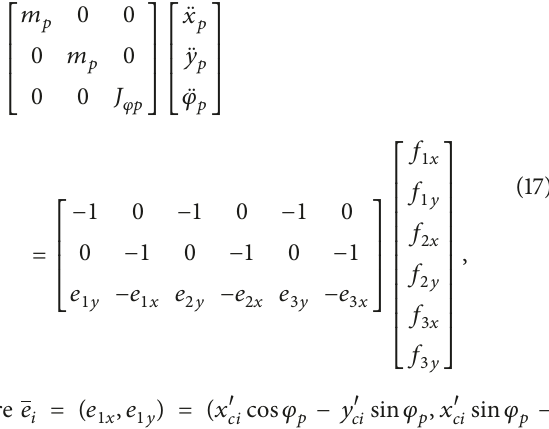
7075. The elastic modulus of the material is 𝐸 𝑖 = 7.1 × = 2.81 × 10 3 kg / m 3 . The 10 10 N / m 2 . The density is 𝜌 𝑖 length, width and thick of the drive rod are 210 mm, 25 mm, and 10 mm, respectively. The length, width, and thick of the flexible intermediate link are 210 mm, 25 mm, and 2 mm, = 8.3 × 10 −3 kg / m 2 . The concentrated drive joint is the 𝐽 𝐴 𝑖 = 2.2 × 10 −3 kg / m 2 . The moment of inertia of section of 𝐵 𝑖 flexible intermediate link is 𝐼(𝑥 𝑖 ) = 1.67 × 10 −11 m 4